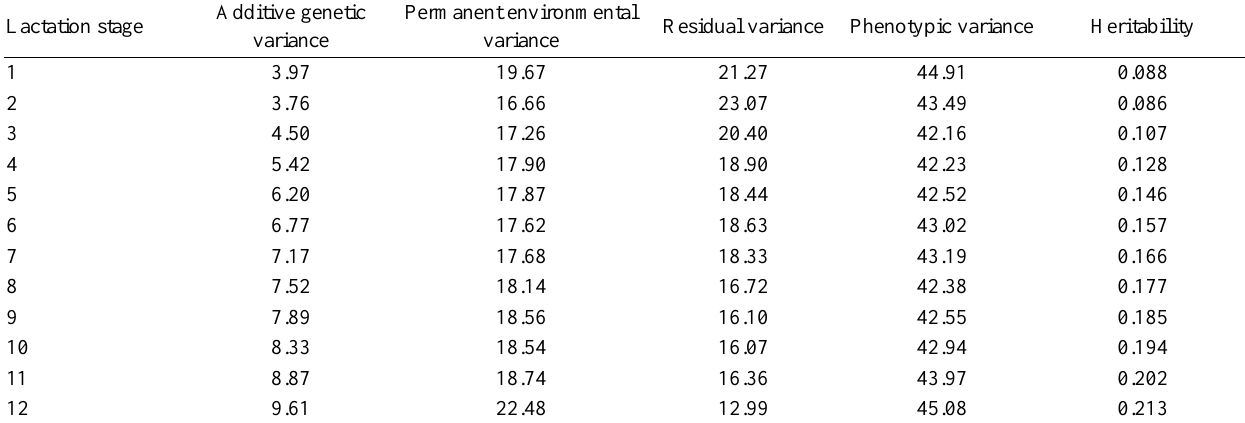
Table 3. Estimates of additive genetic, permanent environmental, residual and phenotypic variances (×10 3 ), and heritability for test day protein yields in different stages of lactation Additive Lactation stage